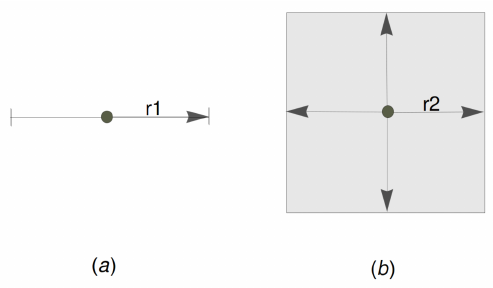
Figure 1. ( a ) Sensing radius r 1 on a line. ( b ) Square sensing radius r 2 .